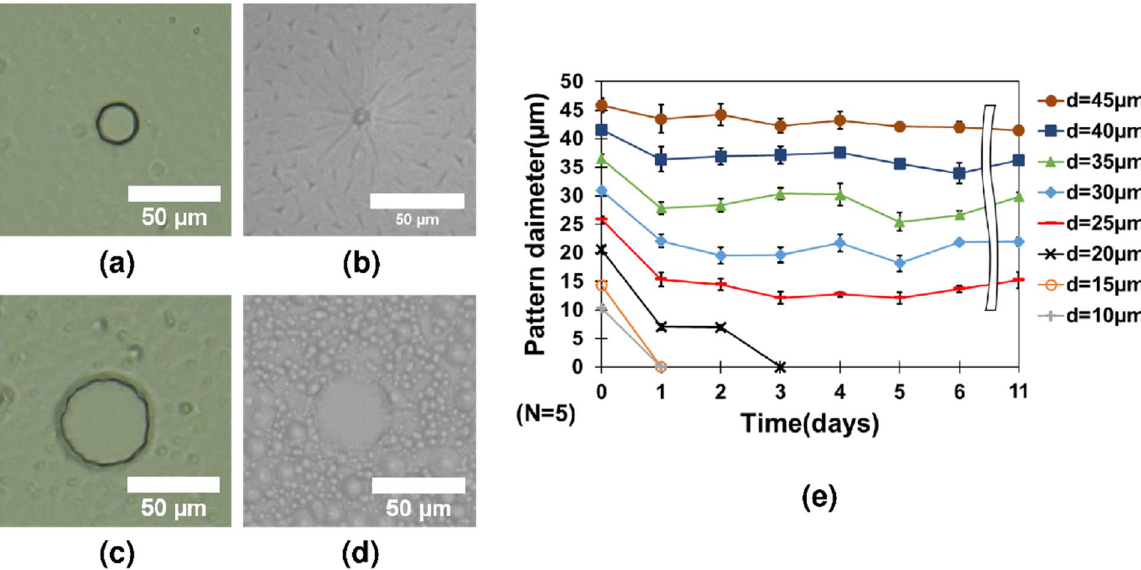
Figure 5. Behavior of microwell patterns under incubation for different timeframes. ( a , b ) The bioresist concave structure (d = 20 µm) was observed after 3 days of incubation. ( c , d ) The bioresist concave structure (d = 45 µm) was observed after 11 days of incubation. ( e ) The behavior of different bioresist patterns at different times of incubation. ( f ) The single-cell trapping efficiency was observed for different microwell diameter sizes.